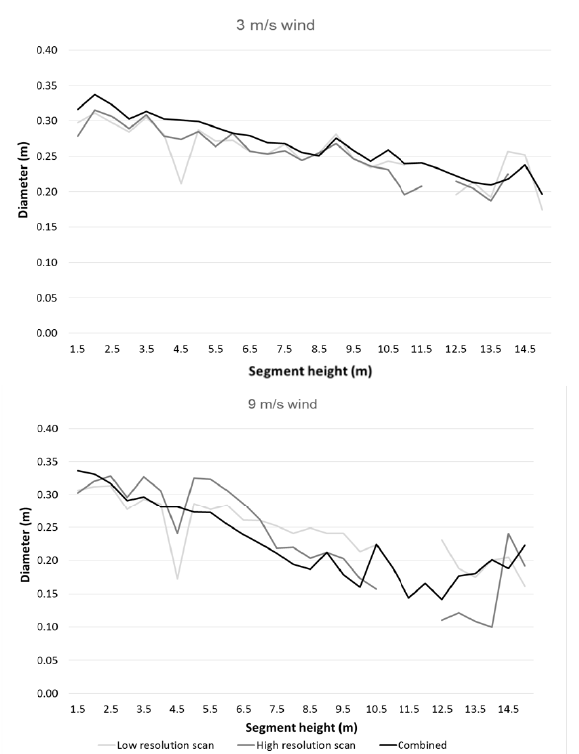
Figure 4. The stem diameter found using circular fittings on different heights under 3 m/s and 9 m/s winds.